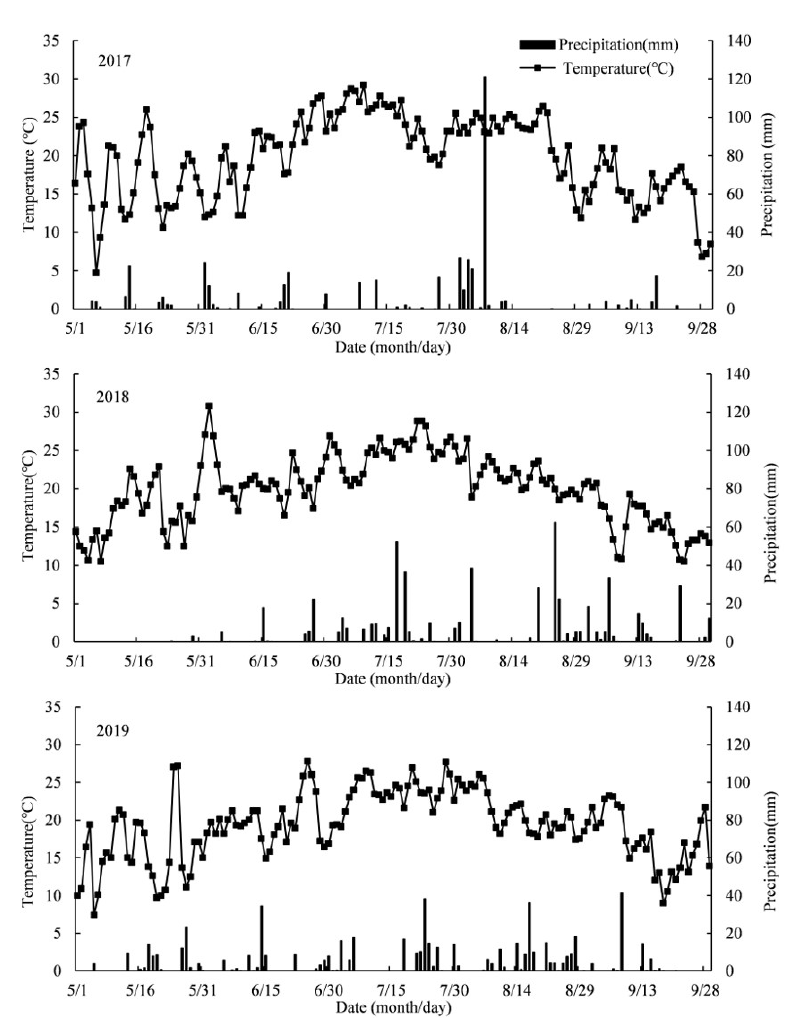
Figure 7. The sketch map of field experiment in 2017 to 2019, Based on the two factor split zone experiments, we identified the optimum mode (OM) as control treatment for omission experiment. The red box was used to show that the plant density (80,000 plants ha − 1 ) and plant spacing (wide ‐ narrow plant spacing) of optimum mode (OM treatment) was selected based on the different plant density and plant spacing tests in the left sub ‐ graph.